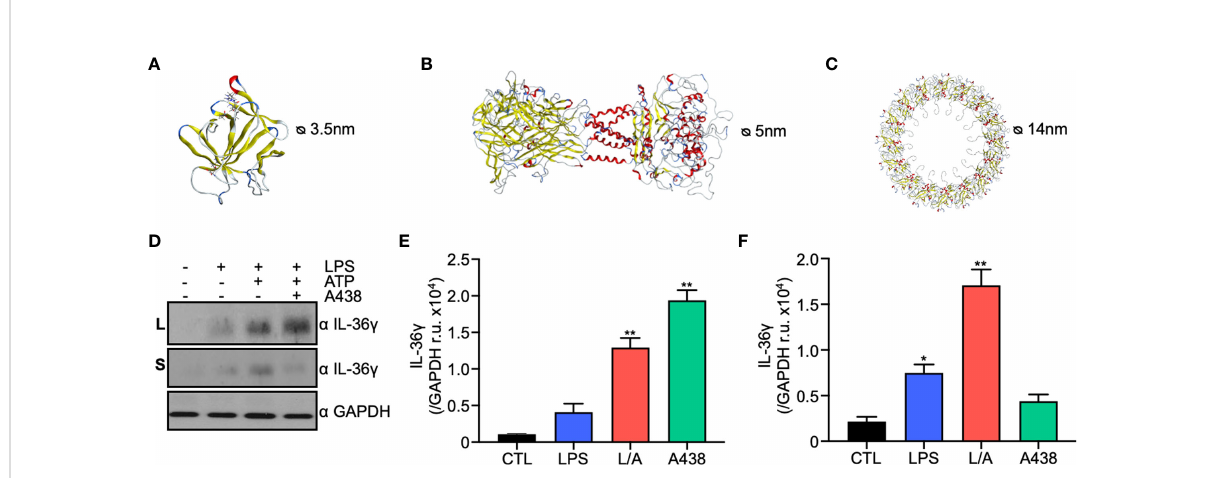
FIGURE 2 IL-36 g is secreted through the membrane pores P2X7R and GSDMD of the unconventional secretory pathway type I. (A) In silico model of mouse IL-36 g generated by SWISS-MODEL. (B) In silico model of P2X7R generated by SWISS-MODEL. (C) In silico model of GSDMD pore generated by SymmDock sever. (D) Western blot of lysates and supernatants under control, LPS, LPS/ATP (L/A), LPS/ATP+A438 conditions. Densitometry of IL-36 g in lysates (E) and supernatants (F) . *p<0.05,